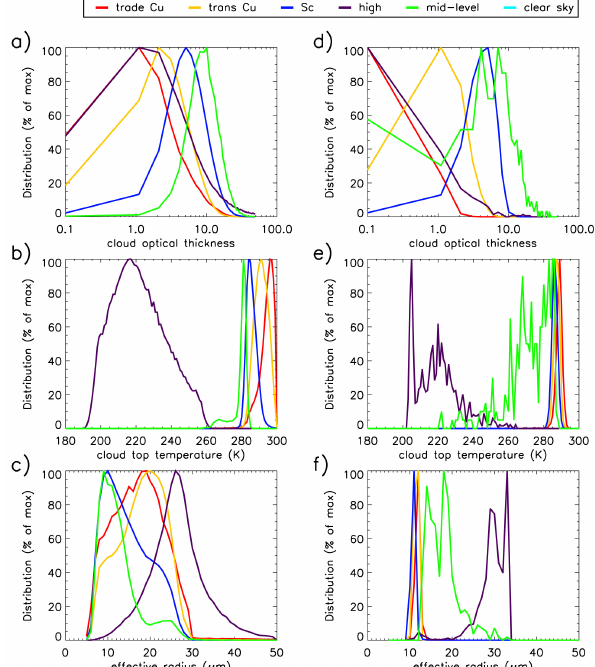
Fig. 3. Cloud-type distributions of τ c (panels a and d ), T c (panels b and e ) and r e (panels c and f ) for the entire 310-day data set. The left column is for the AIRS/MODIS observations, and the right is for